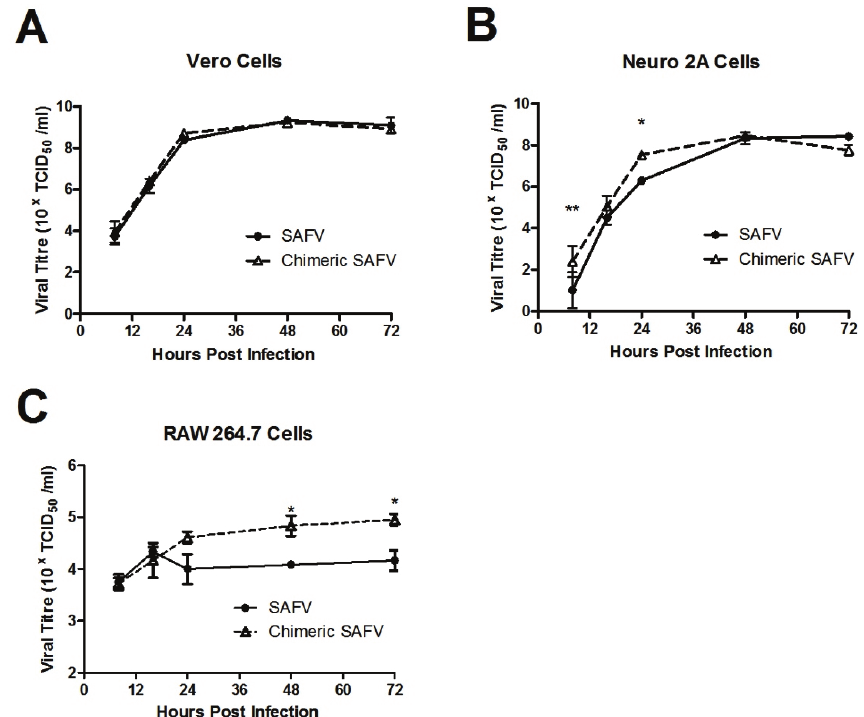
Figure 3. Growth Kinetics of SAFV or chimeric SAFV in Vero ( A ); Neuro2a ( B ) or RAW 264.7 ( C ) cells. Data presented in mean ± SEM. There was an effect in time in all cells, an effect of virus in Neuro2A and RAW 264.7, but not Vero cells, and an effect of interaction only in RAW 264.7, but not Vero or Neuro2A cells. Bonferroni post hoc analysis of Vero cells revealed no significance at any time point. Bonferroni post hoc analysis of Neuro2A cells revealed significannce difference at eight and 16 h time point. Bonferroni post hoc analysis of RAW 264.7 cells revealed difference at 48 and 72 h time point. ** represents p < 0.01, * represents p < 0.05.